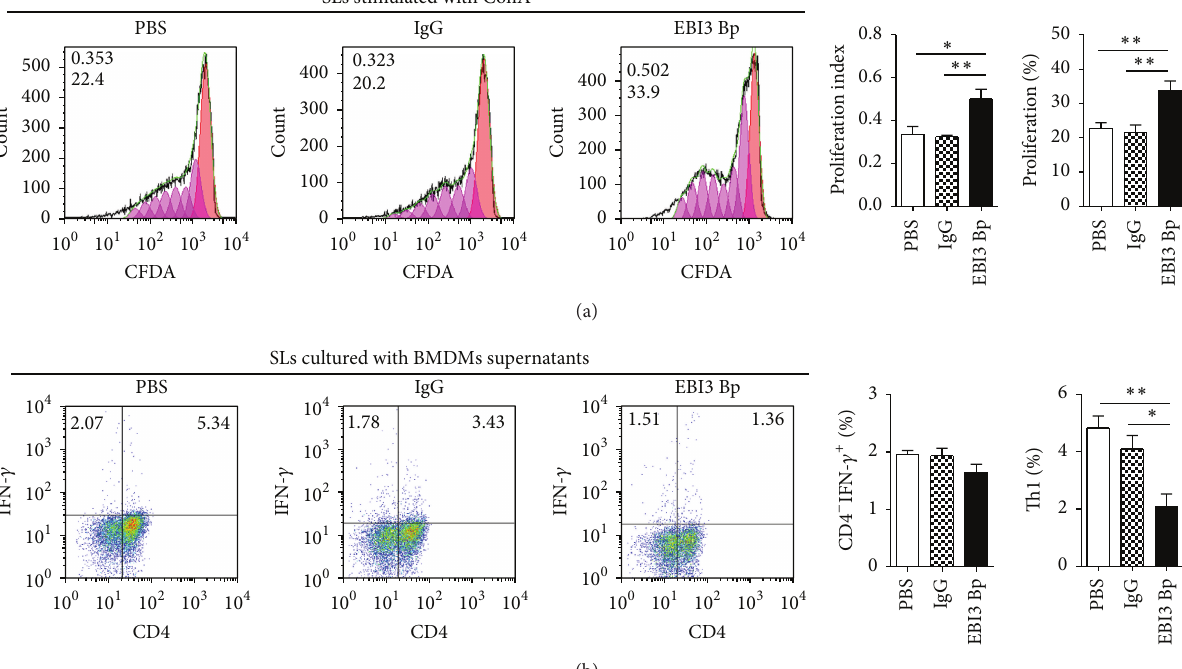
Figure 2: The natural EBI3 signal blocking effect of EBI3 blocking peptide. (a) Mouse splenic lymphocytes (SLs) were isolated from Balb/c mice, SLs were cocultured with or without the indicated doses of EBI3 blocking peptide (EBI3 Bp) in the presence of ConA (1 𝜇 g/mL), and SLs proliferation were detected by CFDA assay. (b) Bone marrow from femurs and tibias of Balb/c mice was cultured in RPMI1640 supplemented with 10% FBS and 10ng/ml murine M-CSF for 6 days and used as mouse bone marrow-derived macrophages (BMDMs). BMDMs pretreated with or without EBI3 Bp for 10min and then stimulated with LPS for additional 1 day. Culture supernatants were used for SLs culture and after 3-day culture, IFN- 𝛾 producing SLs were analyzed by FCM. ∗ 𝑃 < 0.05 ; ∗∗ 𝑃 < 0.01